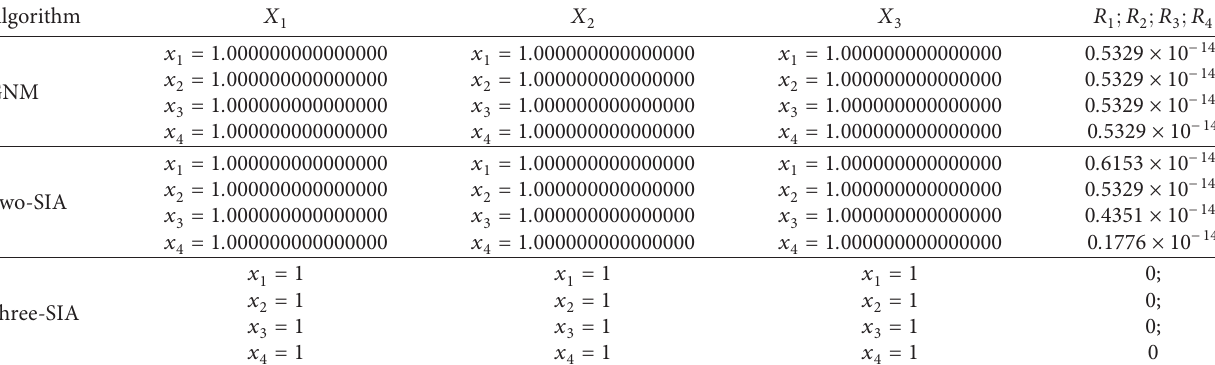
Table 3: The comparison of three-SIA, two-SIA, and GNM for Example